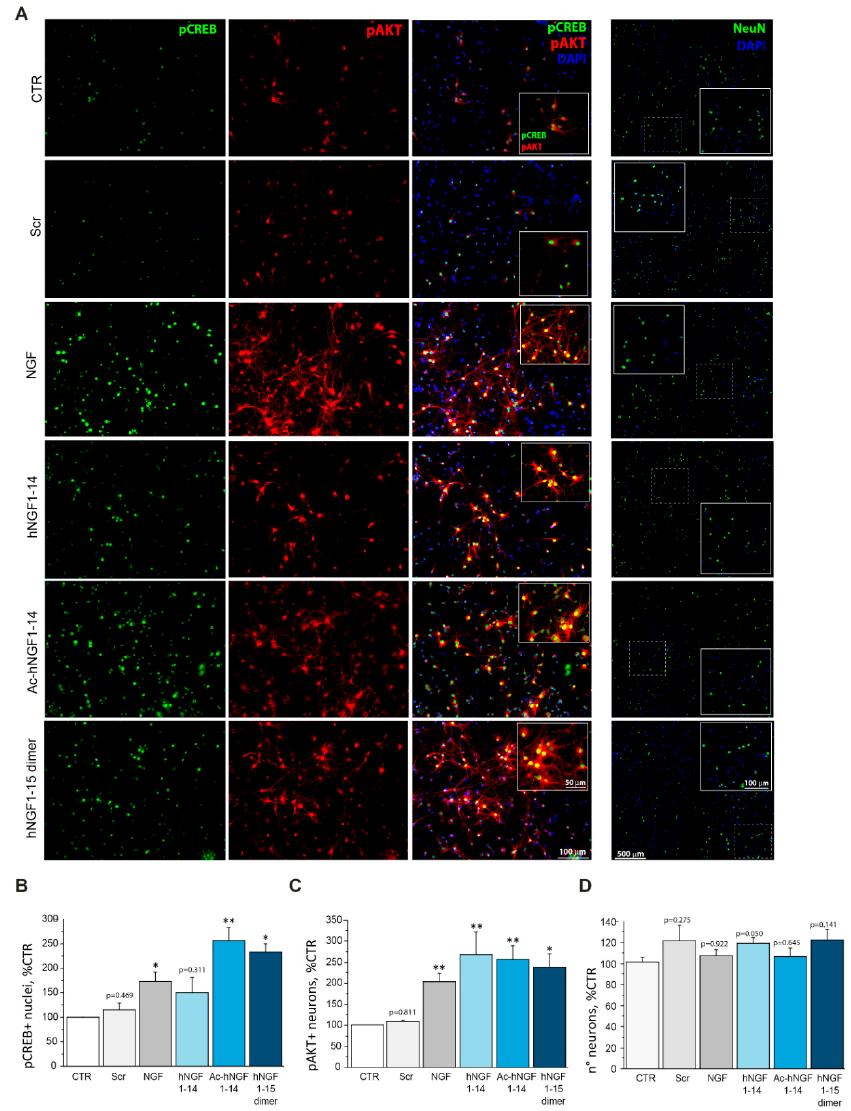
Figure 2. The hNGF1–14 peptides increase the number of pCREB and pAKT expressing cholinergic neurons. ( A – C ) Double immunolabelling and quantitative analysis of pCREB ( A , B ; green colour) and pAKT ( A , C ; red colour) single positive DIV1 cholinergic neurons per field (20 × objective) following 20 (cid:48) incubation with 10 µ M each of scrambled hNGF1–14 (Scr), hNGF1–14, Ac-hNGF1–14, and hNGF1–15 dimer and 100 ng / mL (3.84 nM) NGF. Nuclei were counterstained with DAPI (blue colour). The pCREB and pAKT positive neurons were counted, expressed in percentage of CTR and compared.